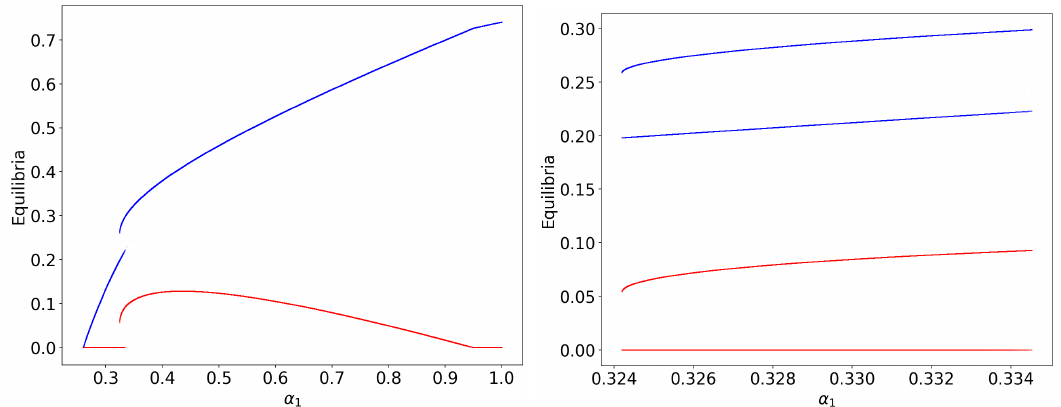
( ε ,1 ) as control parameter for a set of ∈ ( α c ) and in red for x ∗ coordinates. ( Right ) Close up of the diagram for α 1 , α − 2 1 1 1 ∈